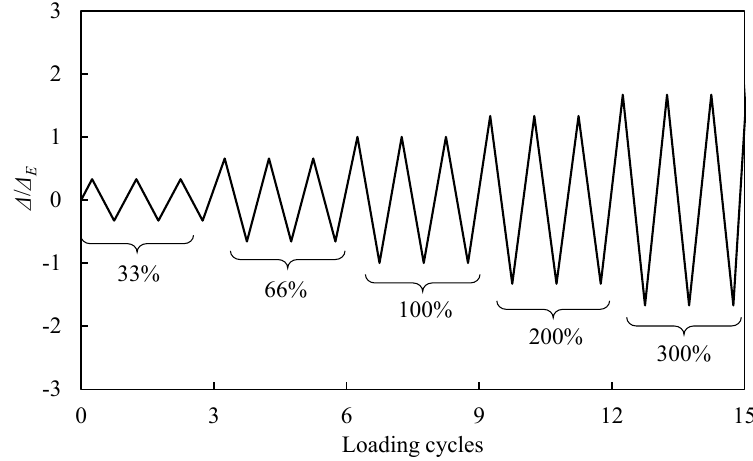
Figure 4. History of the cyclic loading.